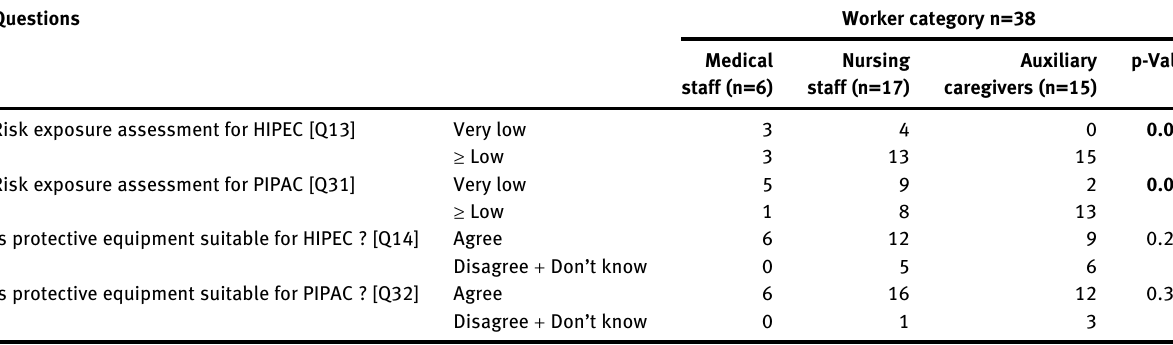
Table  B: Perception questions by worker